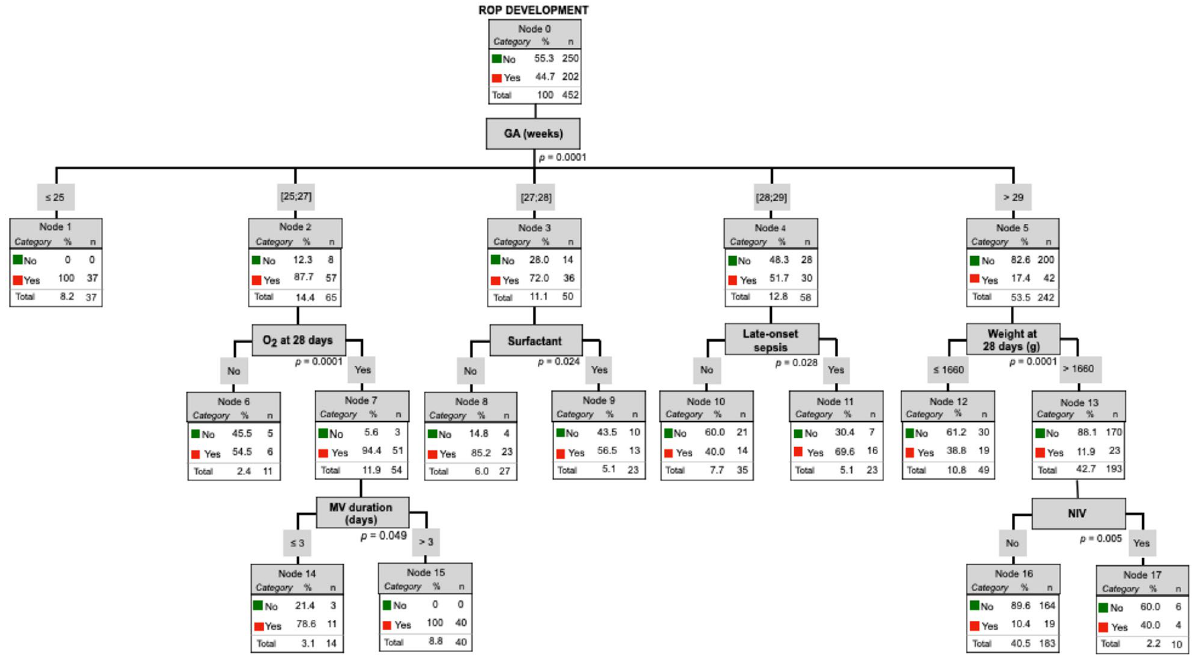
Figure 2. Tree algorithm for ROP development. GA gestational Age (weeks), MV mechanical Ventilation, NIV non-invasive ventilation. *p < CMV, treatment for CMV, NEC, hypotension, intubation, steroids for BDP, apneas, surfactant administration, IVH and anemia) and progression (Fig. 3) (duration of oxygen therapy, nasal high-flow therapy, HFOV, weight at 28 days of life, late-onset sepsis, ROM, weight at ROP diagnosis, hypotension, PDA, intubation, steroids for BDP, surfactant administration, IVH and anemia).